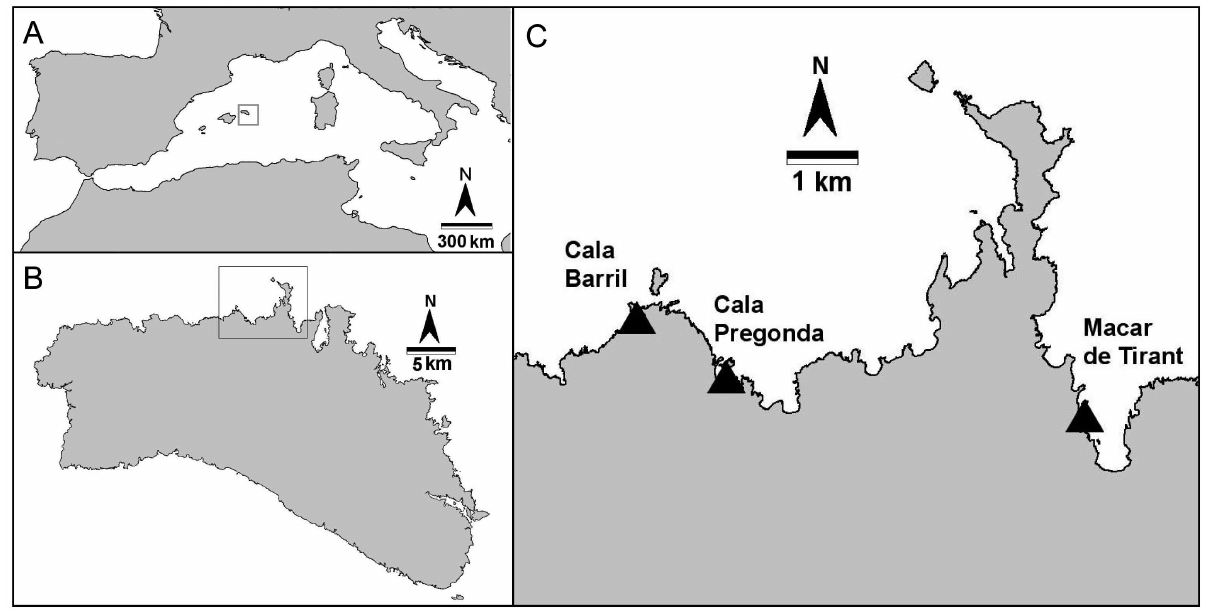
Fig . 1. – Map of the study area showing the locations of the study